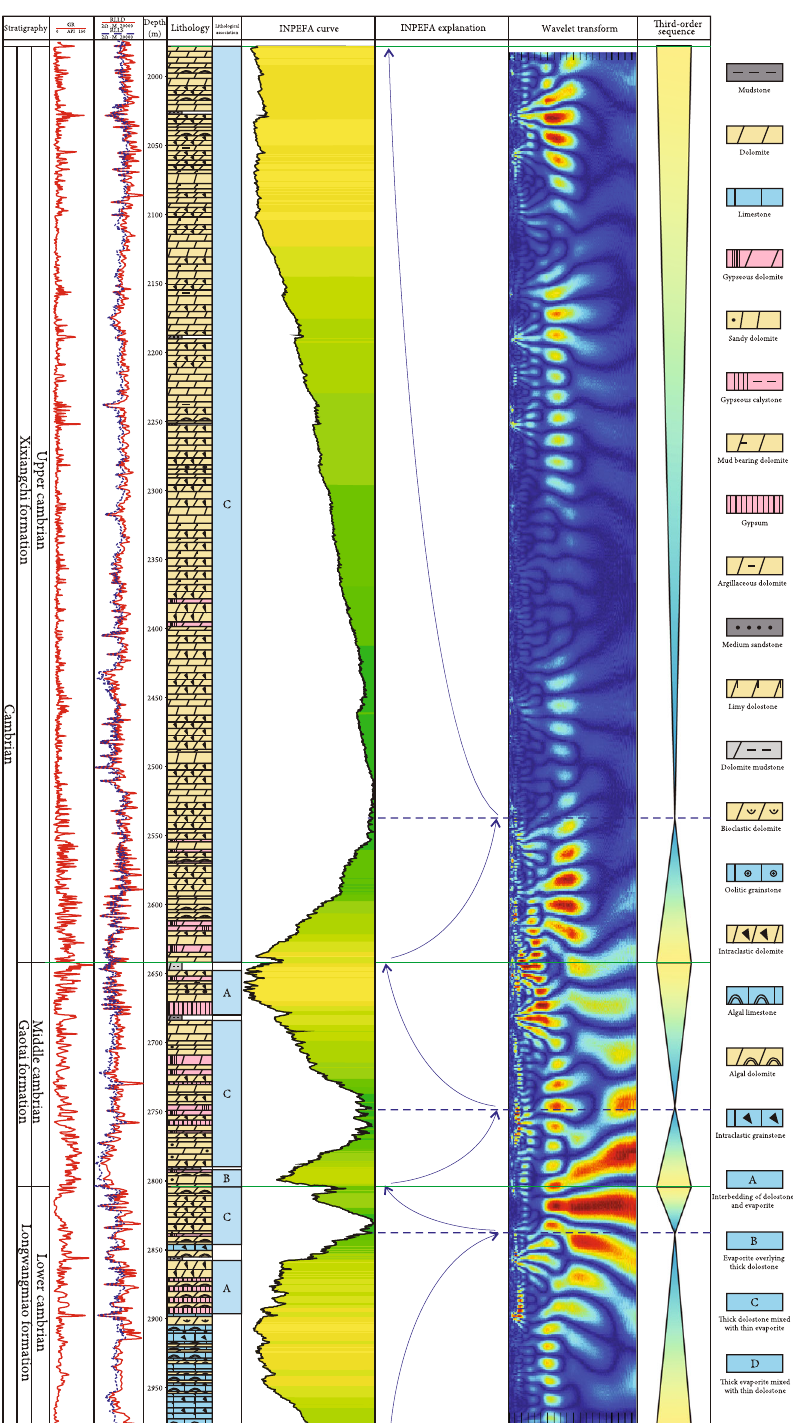
Figure 5: The Longwangmiao Formation, the Gaotai Formation, and the Xixiangchi Formation of Dingshan 1